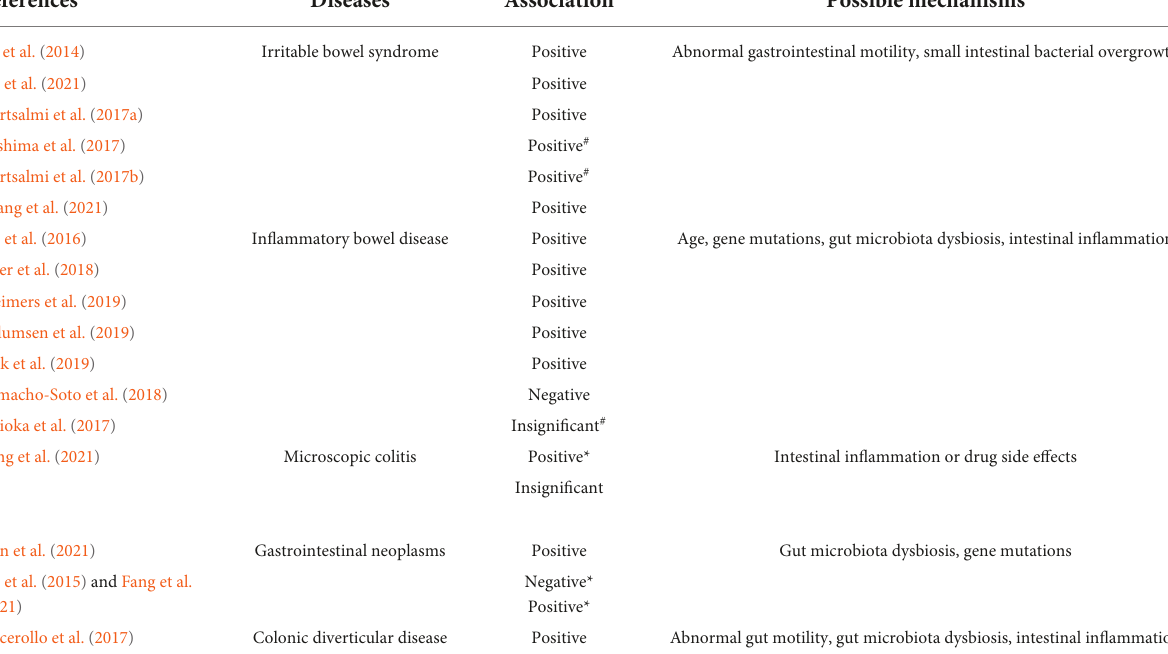
TABLE 3 The link between Parkinson’s disease and gastrointestinal